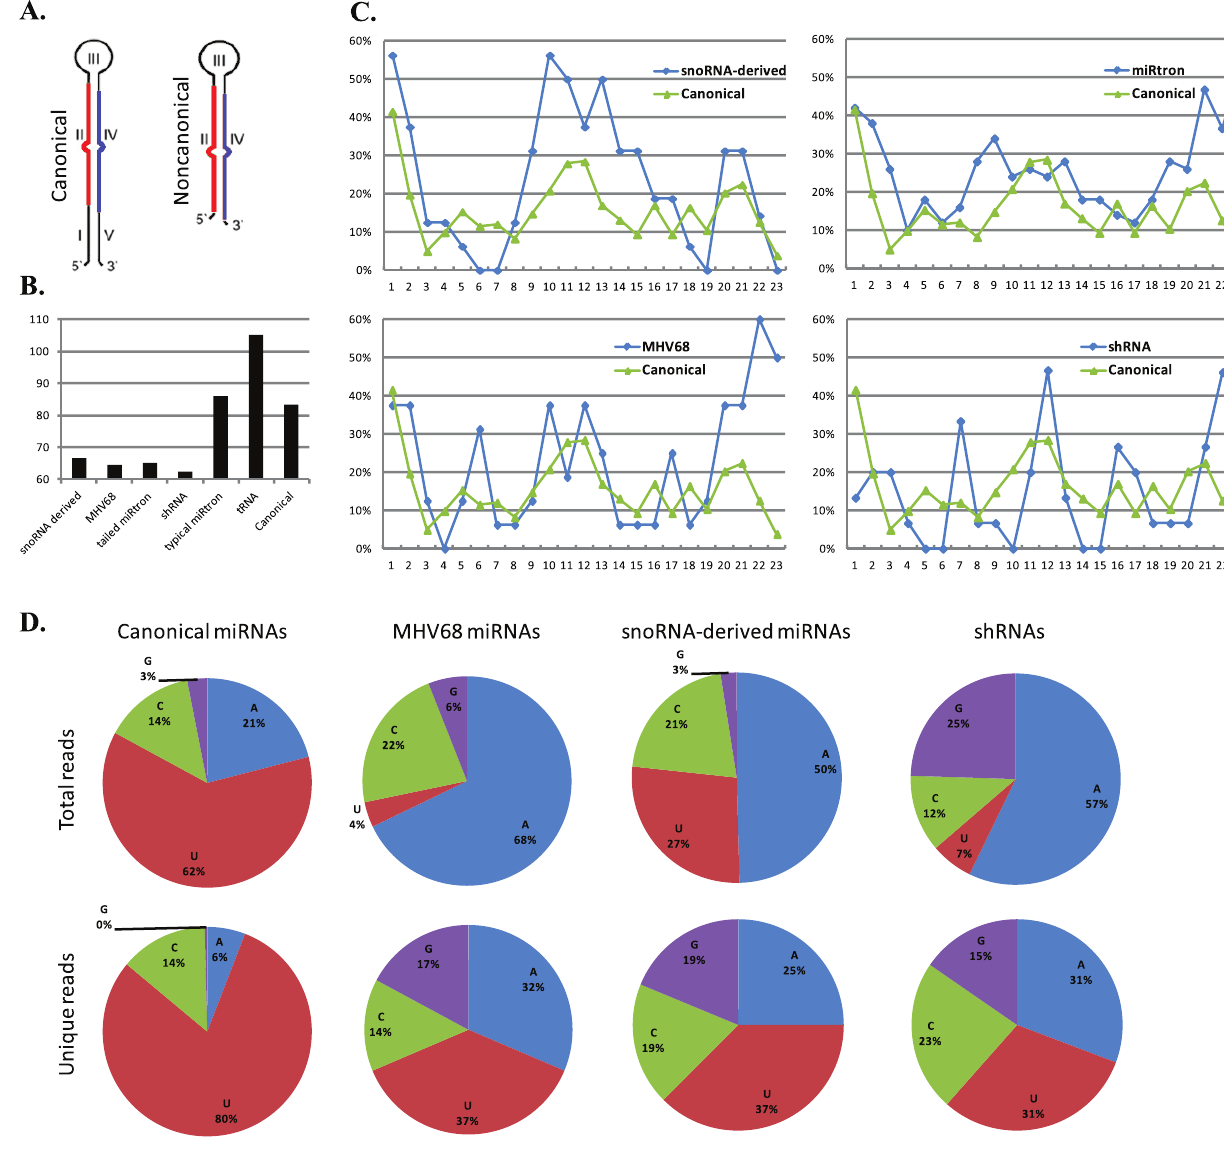
Figure 4. Features of canonical and noncanonical miRNAs. (A) A diagram marks the locations of the five regions for canonical miRNA hairpins: I, loop-distal (5 9 arm); II, miRNA-5p; III, loop-proximal; IV, miRNA-3p; V, loop-distal (3 9 arm). Noncanonical miRNA hairpins miss I and V loop-distal regions. (B) The average length of hairpins for canonical miRNAs, snoRNA-, tRNA-derived miRNAs, miRtrons (typical and tailed) and MHV68-encoded miRNAs (C) The percentage of the number of unpaired bases at each position (from 5 9 to 3 9 ) for canonical (green) and noncanonical (blue) miRNAs, respectively. (D) First nucleotide percentage of total reads (upper) in MHV68 data mapped to conserved, MHV68 encoded, snoRNA-derived miRNAs and shRNAs. Percentages of unique miRNAs are presented in the lower part,